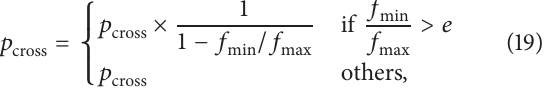
Figure 4: Average curve